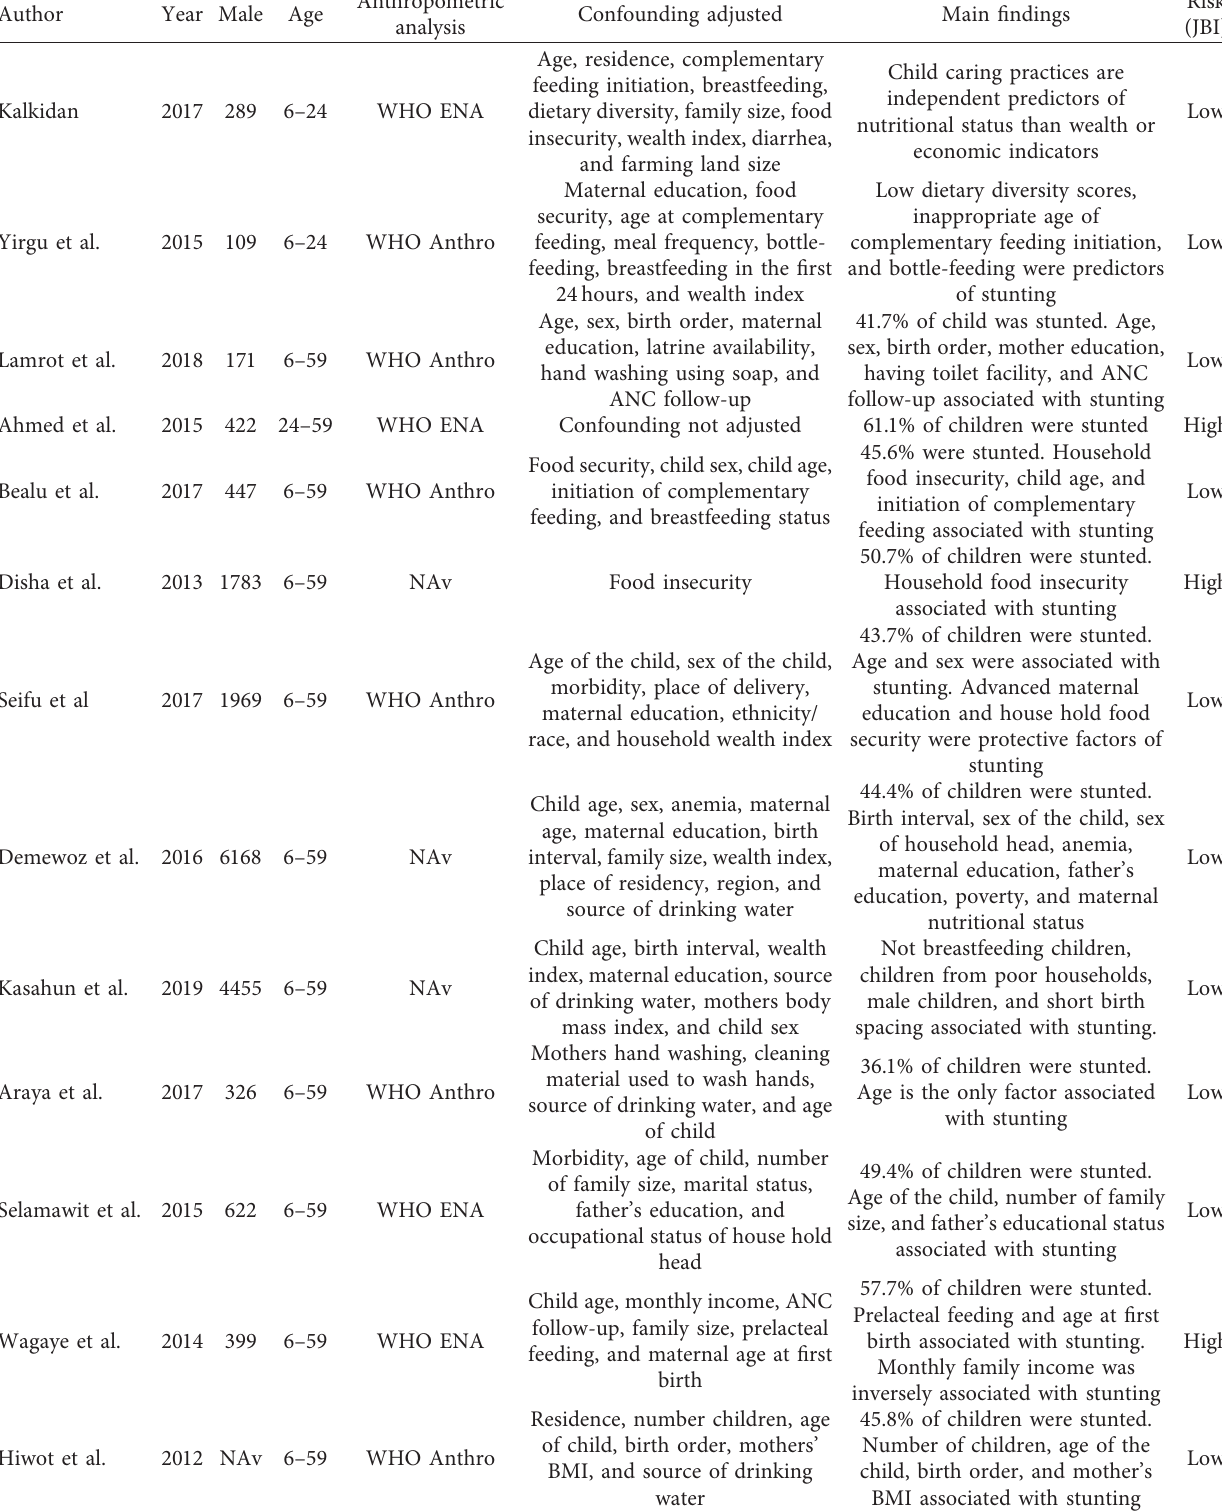
Table 2: The main findings and quality assessment reports of the selected studies conducted from 2010 to 2019 about stunting in